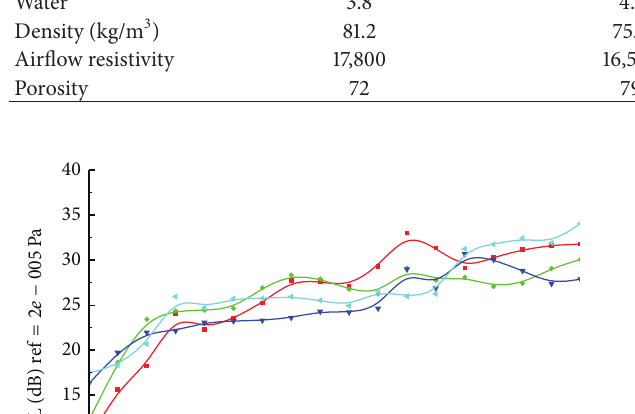
10012516020025031540050063080010001250160020002500315040005000